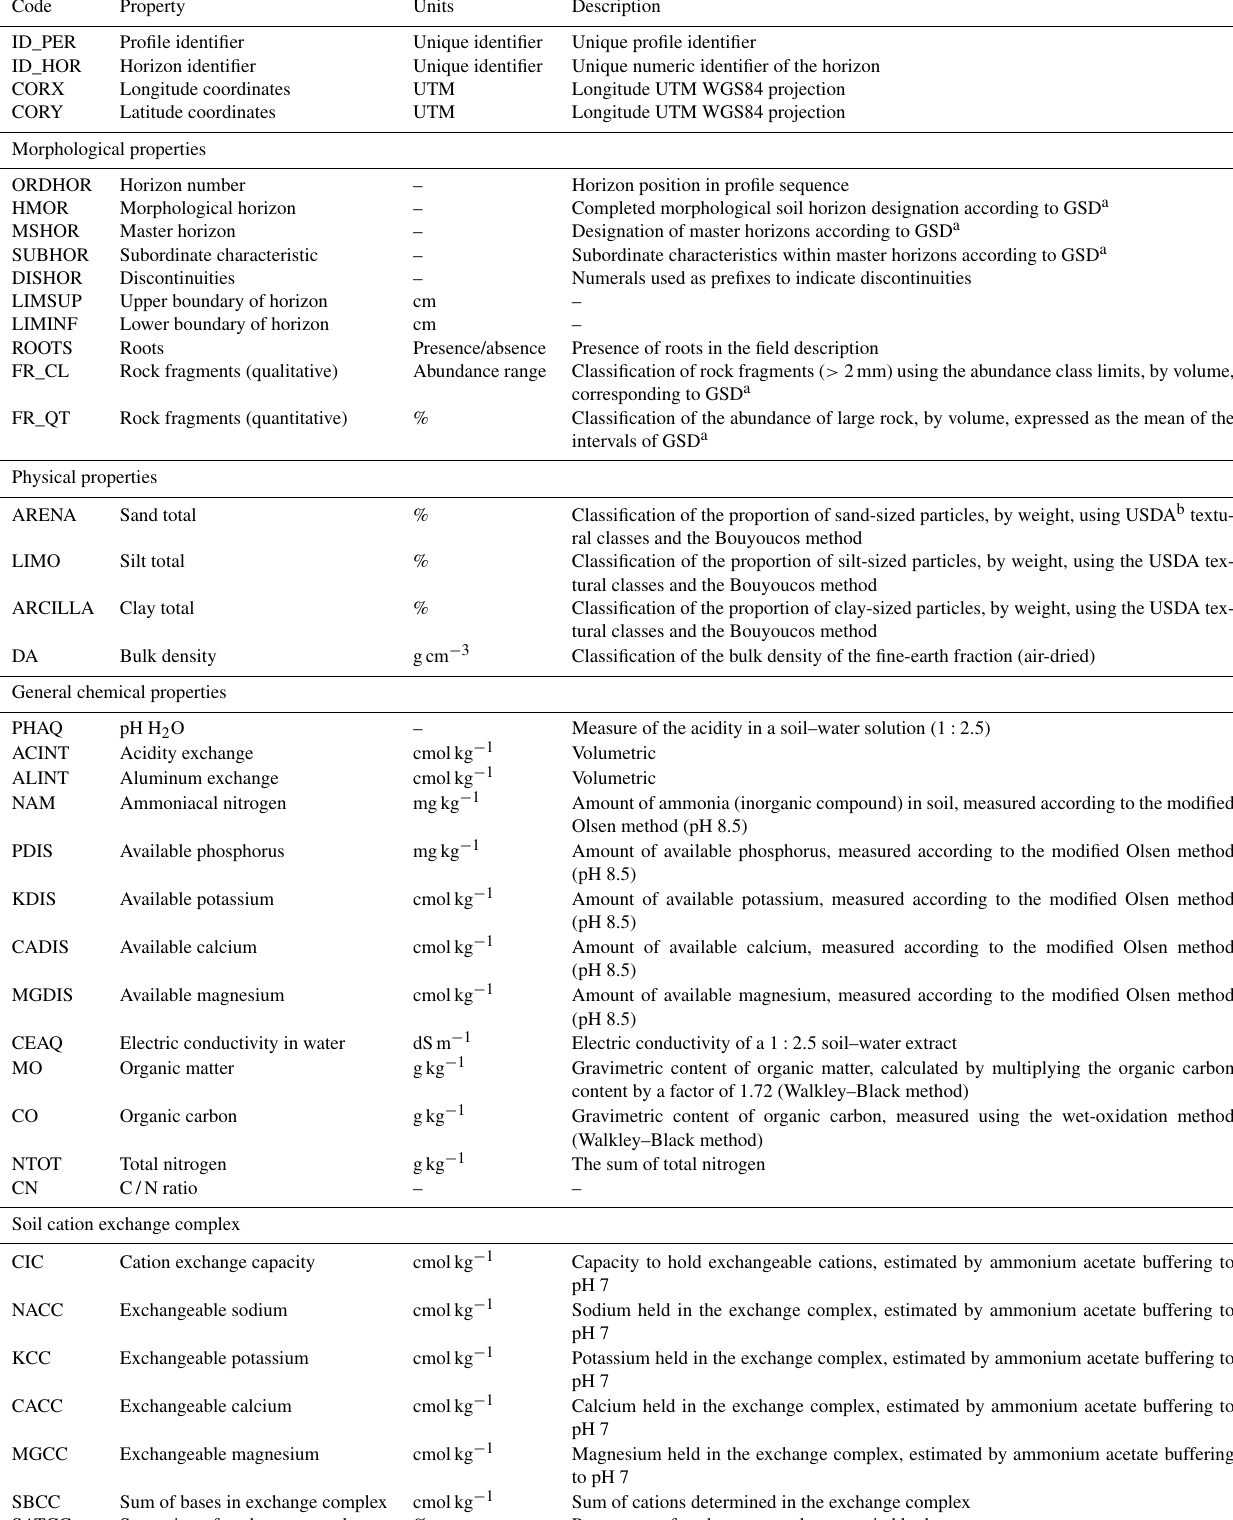
Table 2. The HESD horizon coding conventions and soils property names, units of measurement, and